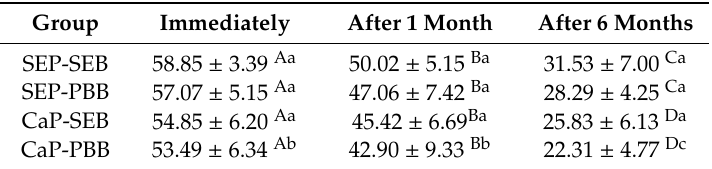
Table 2. The mean value of mineral loss values Δ Z (vol%.µm) at the 3 time points. Identical superscript letters indicate significant differences within each treatment period. ( p ≤ 0.05).